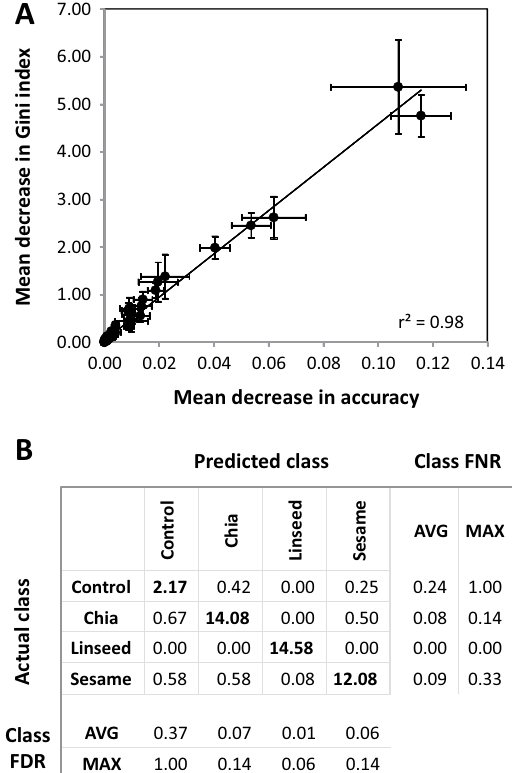
Figure 6. RF based selection of seed identity markers from mass features of non-targeted metabolite profiles of experimental bakery products that were prepared with or without additions of chia, linseed, or sesame seeds. ( A ) Analysis of variable importance by mean decrease of Gini index and mean decrease of accuracy measures (means ± standard deviations) of 12 random forest analyses using 84 pre-selected processing-dependent mass features and eight manually added mass features containing previously identified markers of non-processed seeds. These mass features were selected from 19761 mass features of a non-targeted metabolite profiling analysis of polar extracts from experimental cookies that were prepared with 5, 10, 15, or 20% (w/w) defatted seed flour or 10 or 20% (w/w) whole seeds (Supplemental Table S4). The classification models predicted four classes, cookies without added seeds and cookies with chia, linseeds or sesame seeds irrespective of amount of added seed material or seed pre-processing. The importance of top mass features was ranked according to mean decreases in accuracy (Supplemental Table S4). ( B ) Characterization of the trained classification models by a confusion matrix, class false negative rates (FNR) and class false discovery rates (FDR). Averages (AVG) and maxima (MAX) of class FNR and FDR were calculated from the individual confusion matrices of 12 classification models that were trained from 46 random samplings of a total set of 93 profiles of cookies without added seeds (n = 5) and cookies with chia (n = 28), linseeds (n = 30) or sesame seeds (n = 30). The overall classification error was 6.70 ± 3.27% (mean ± standard